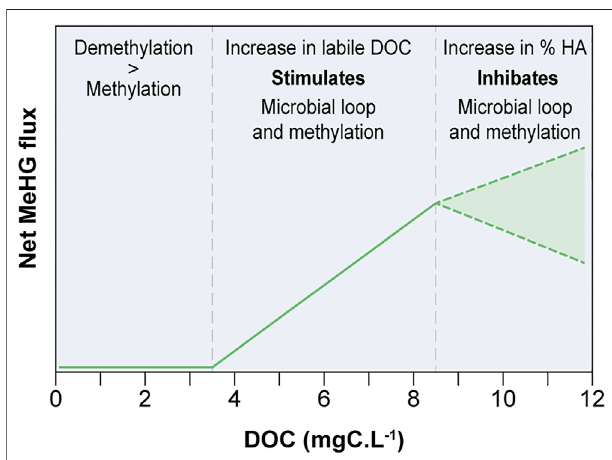
FIGURE 3 | Conceptual representation of the in fl uence of DOC concentration on net aquatic MeHg fl ux in freshwater. HA: Humic acids (adapted from French et al. (2014), Soerensen et al. (2017)). Dash lines represent the limit of the probable variation of the net MeHg fl ux.